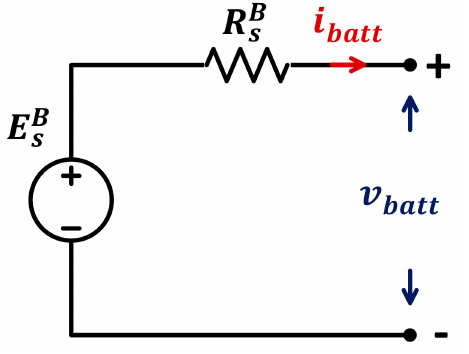
Figure 10. Battery generic